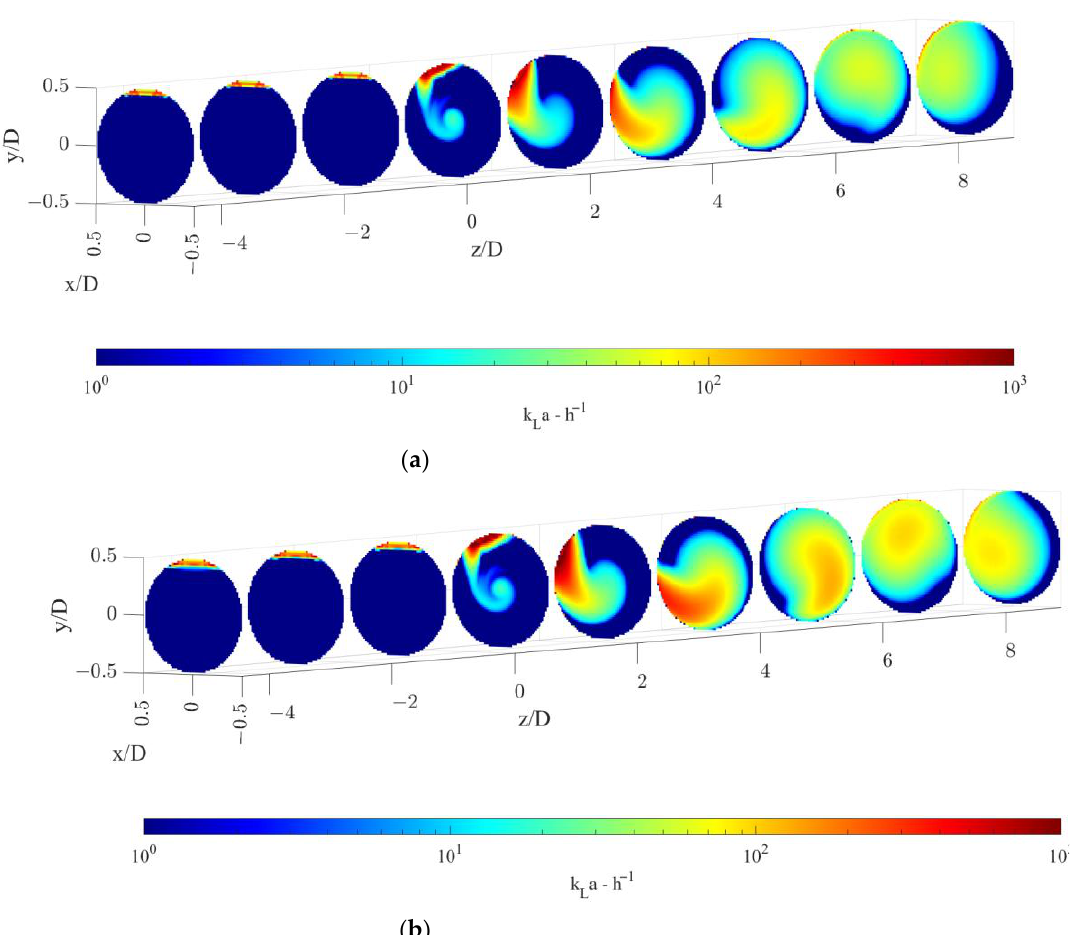
Figure 6. Volumetric mass transfer coefficient on radial pipe cutaway surfaces for the operative conditions considered: ( a ) Q L = 25 m 3 /h and Q G = 3.75 L/min; ( b ) Q L = 30 m 3 /h and Q G = 7.5 L/min. The static mixer is placed at − 0.14 < z/D < 0 and fluids move from left to right. The initial and final part of the pipe are omitted to improve readability.